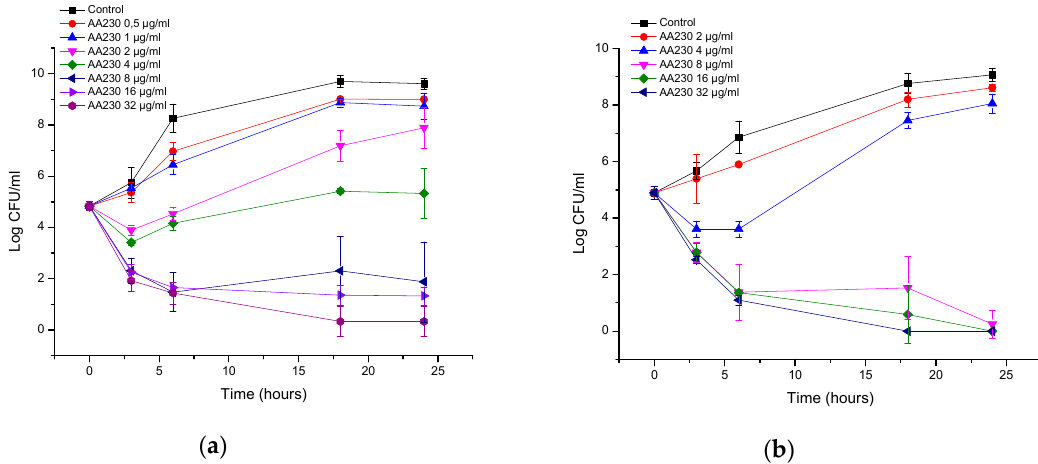
Figure 3. Time-kill curves of antimicrobial peptide AA230 against ( a ) Pseudomonas aeruginosa ATCC (American Type Culture Collection); ( b ) Pseudomonas aeruginosa clinical isolate.